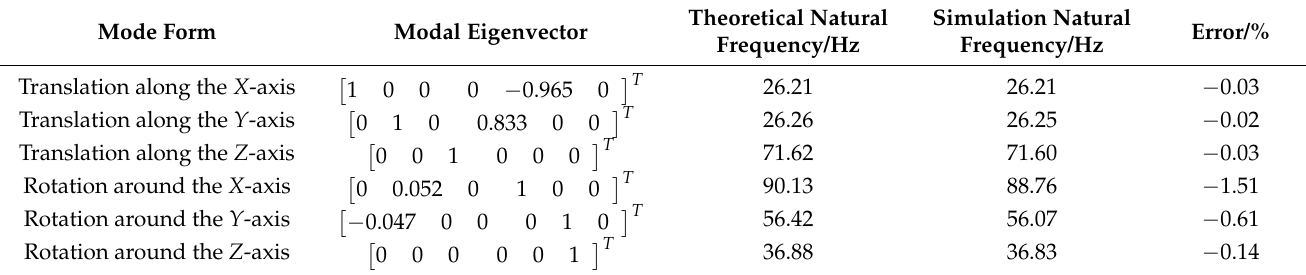
Table 1. Comparison of solved mode results of Stewart platform without flexible joints